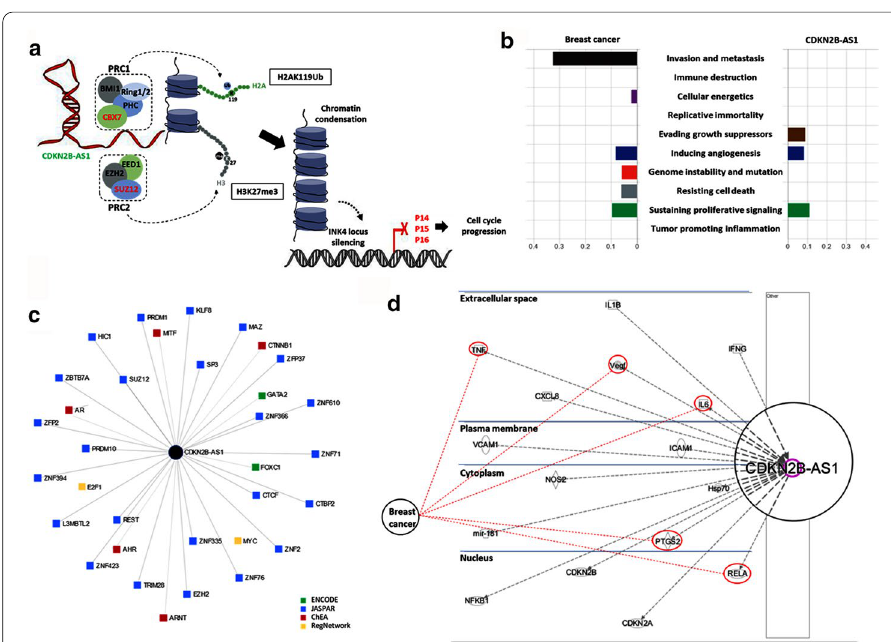
Fig. 9 Functional role of CDKN2B in cancer. a In cis and in trans gene regulation of CDKN2B-AS1 through chromatin modification complexes. CDKN2B-AS1 acts as docking for the epigenetic regulators, PRC1 and PRC2 polycomb complexes, to modify the histone code. The PRC1 complex includes multiple subunits, such as PHC, CBX7, BMI1, and RING1a/1b, which are implicated in the maintenance of silencing by catalyzing monoubiquitination of histone H2A (H2AK119ub1). The PRC2 complex comprises the JARID2, EED, SUZ12, and EZH2 subunits which maintain chromatin repression by catalyzing mono-/di-/trimethylation of histone H3 lysine 27 (H3K27me1, H3K27me2, and H3K27me3). b Automatic CHAT classification of the PubMed literature according to the hallmark of cancer taxonomy. Breast cancer and CDKN2B-AS1 (data are shown as NPMI; normalized pointwise mutual information) were compared. Each bar demonstrates cancer hallmark and/or biological process association with the search query. c Transcription factors-gene network in Network Analyst. A total of 34 nodes representing TF-gene interactions with the lncRNA CDKN2B-AS1 and edges with length representing the degree of association score. Different databases were used: ENCODE, JASPAR, ChEA, and RegNetwork. d Ingenuity Pathway Analysis. A gene network was built to connect key genes highly enriched with the lncRNA. The direction of activity (activation/inhibition) is shown. Five molecular targets involved in breast cancer are further connected in